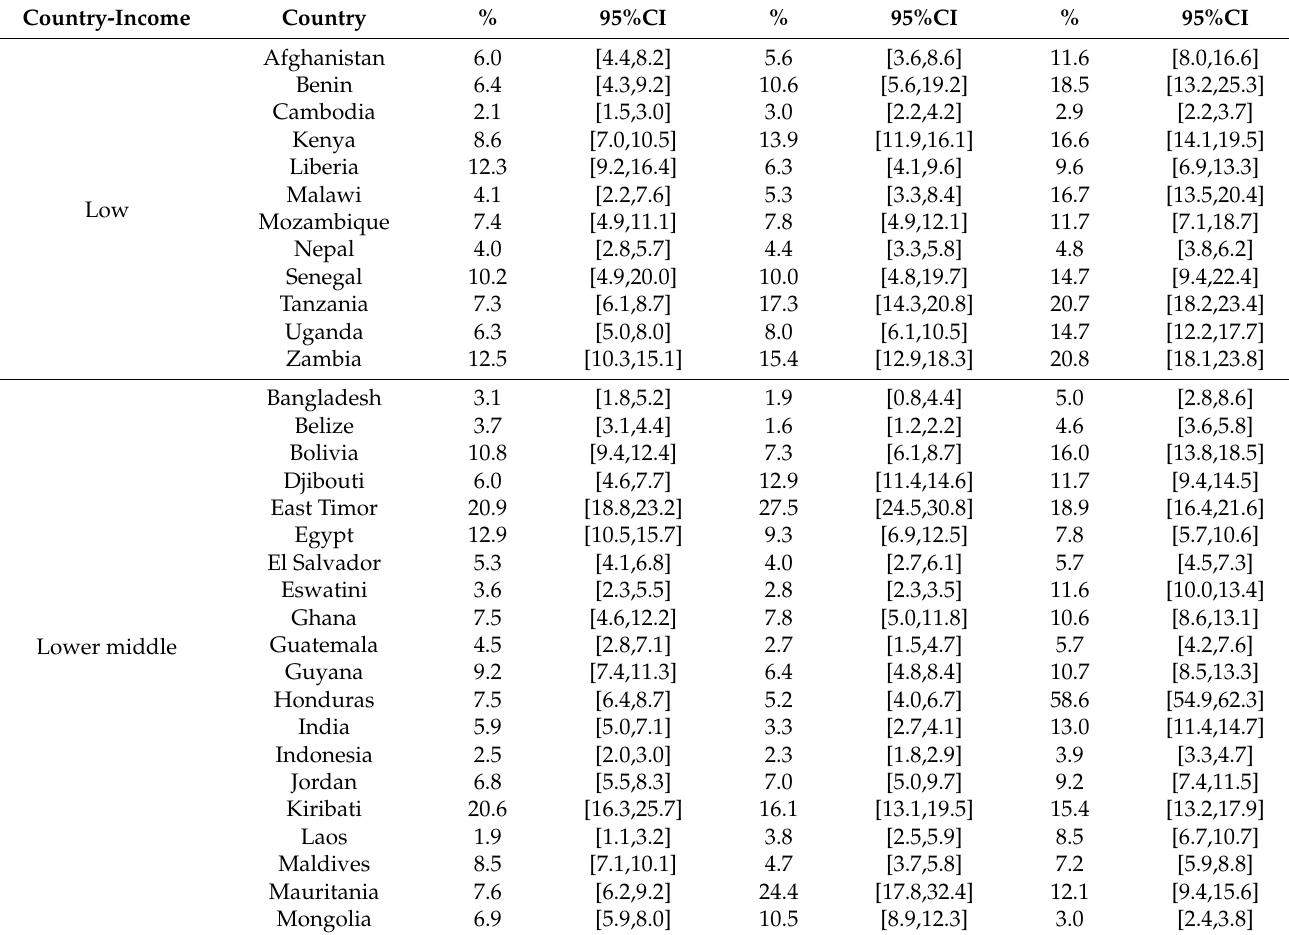
Table 2. Prevalence of never/rarely washing hands before eating, after using toilet, and with soap by country. Country-Income